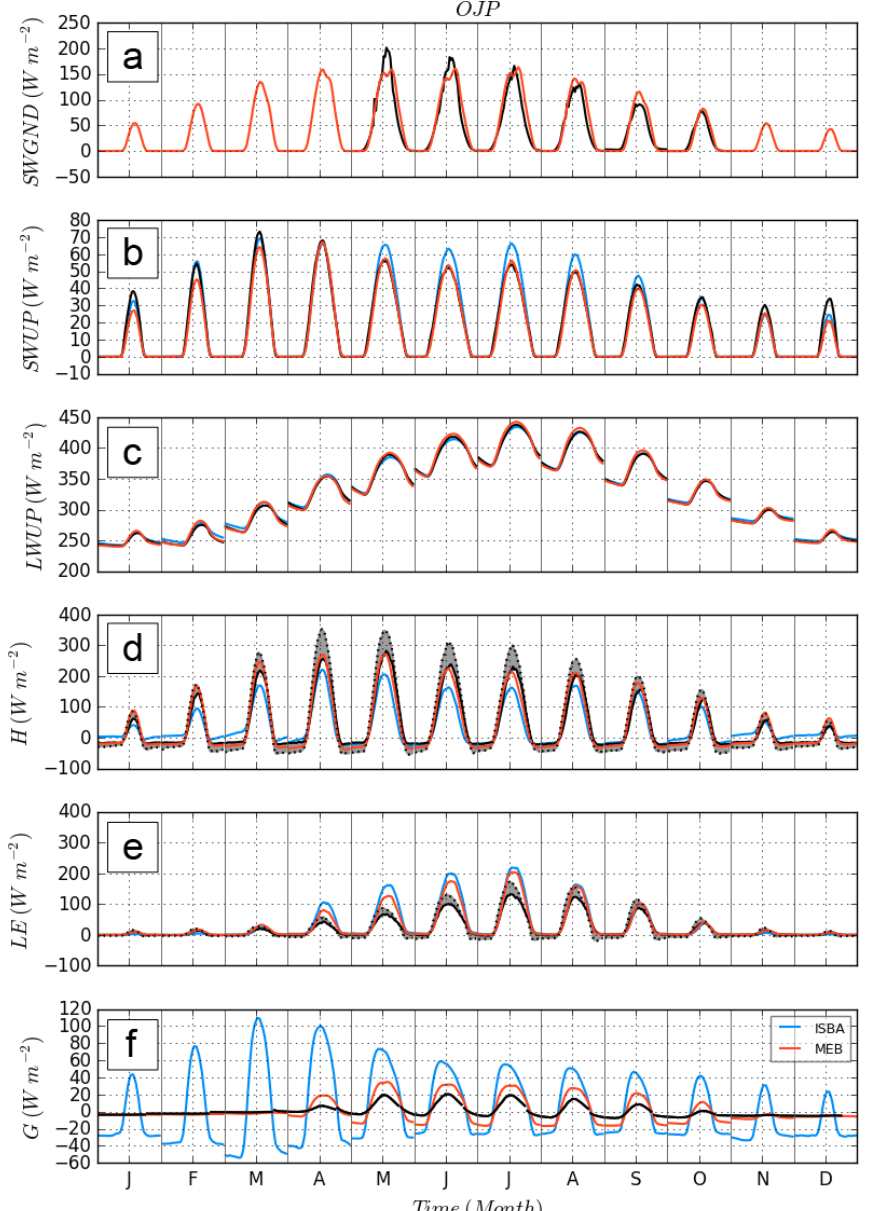
Figure 3. Composite of monthly diurnal cycle at the OJP site. MEB is in red, ISBA in blue, measurements are indicated by a solid line, and adjusted measurements are represented using a dashed black line. Adjusted measurements respect the energy balance closure and are calculated following the method of Twine et al. (2000). As a visual aid, the area between the latter two is shaded and model outputs should fall within this